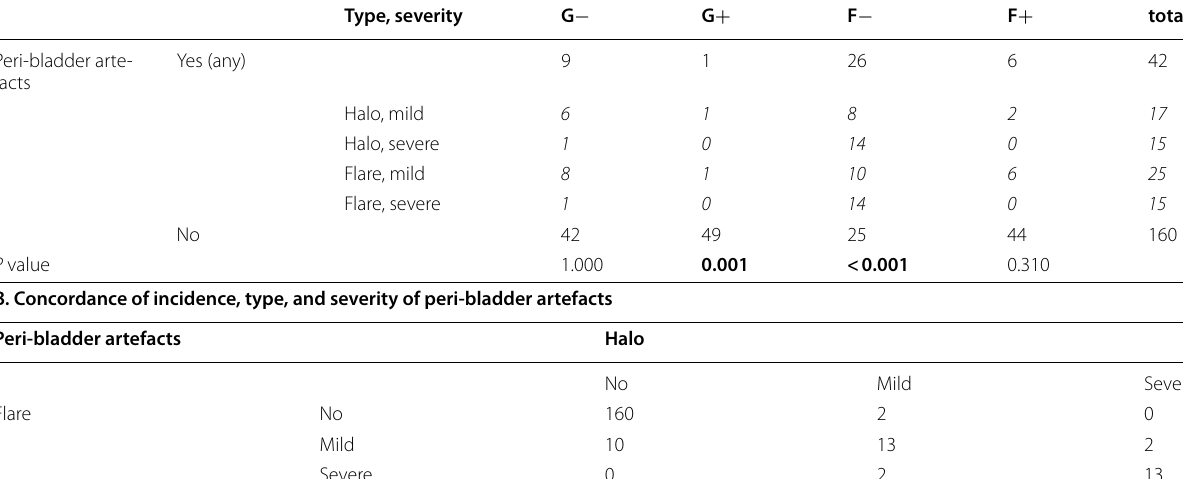
Table 6 A. Observed frequencies ( n ) and overall differences (Fisher’s exact test) in incidence of peri‑bladder artefacts between the cohorts. Results from post hoc pairwise Z‑tests with Bonferroni correction for multiple testing are shown as p values per cohort. B. Concordance of incidence, type, and severity of peri‑bladder artefacts. C. Logistic regression analysis assessing the relation between administration of furosemide or choice of tracer on the incidence of peri‑bladder artefacts